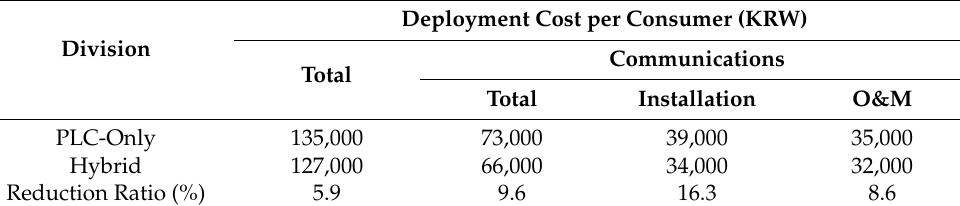
Table 10. Cost per Consumer by Deployment Method.